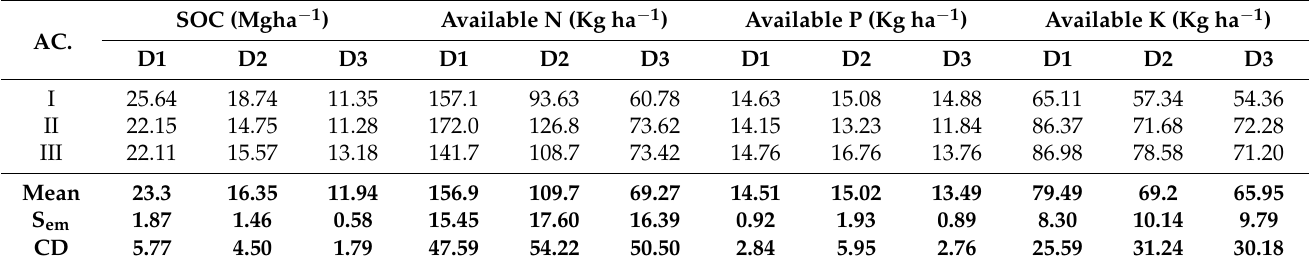
Table 4. Soil organic carbon and available nitrogen, phosphorus and